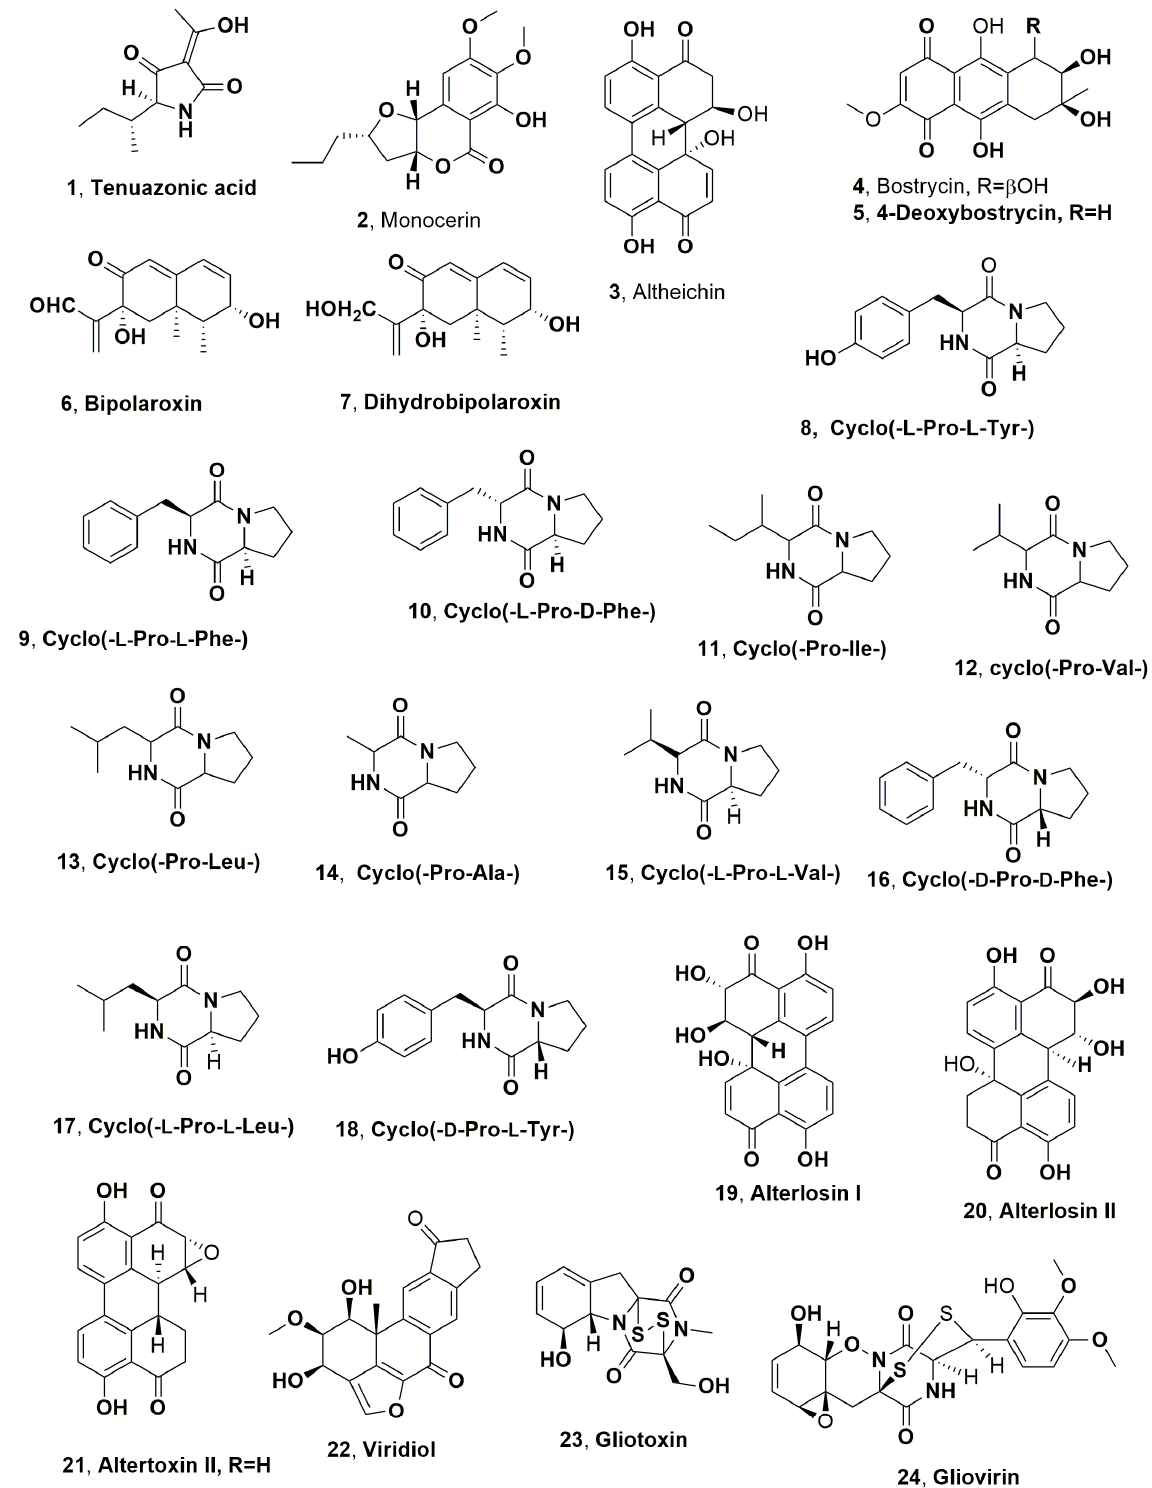
Figure 1. Metabolites produced by Alternaria alternata ( 1 , 8 – 14 , 19 – 21 ), Exserohilum turcicum ( 2 ), Alternaria eichorniae ( 3 – 5 ), Bipolaris cynodontis ( 6 and 7 ), Lysobacter capsici ( 15 – 18 ) and Gliocladium virens ( 22 – 24